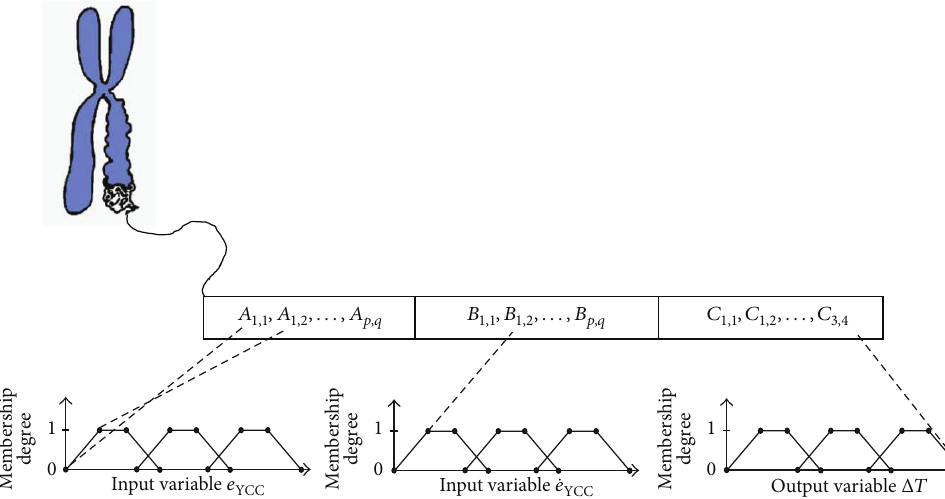
Figure 3: Illustrative representation and coding scheme of input and output fuzzy set parameters on a chromosome. For example, 𝐴 1,1 is the first parameter of the fuzzy set low of the input variable 𝑒 chromosome, where 𝐵 denotes the second input variable ̇𝑒